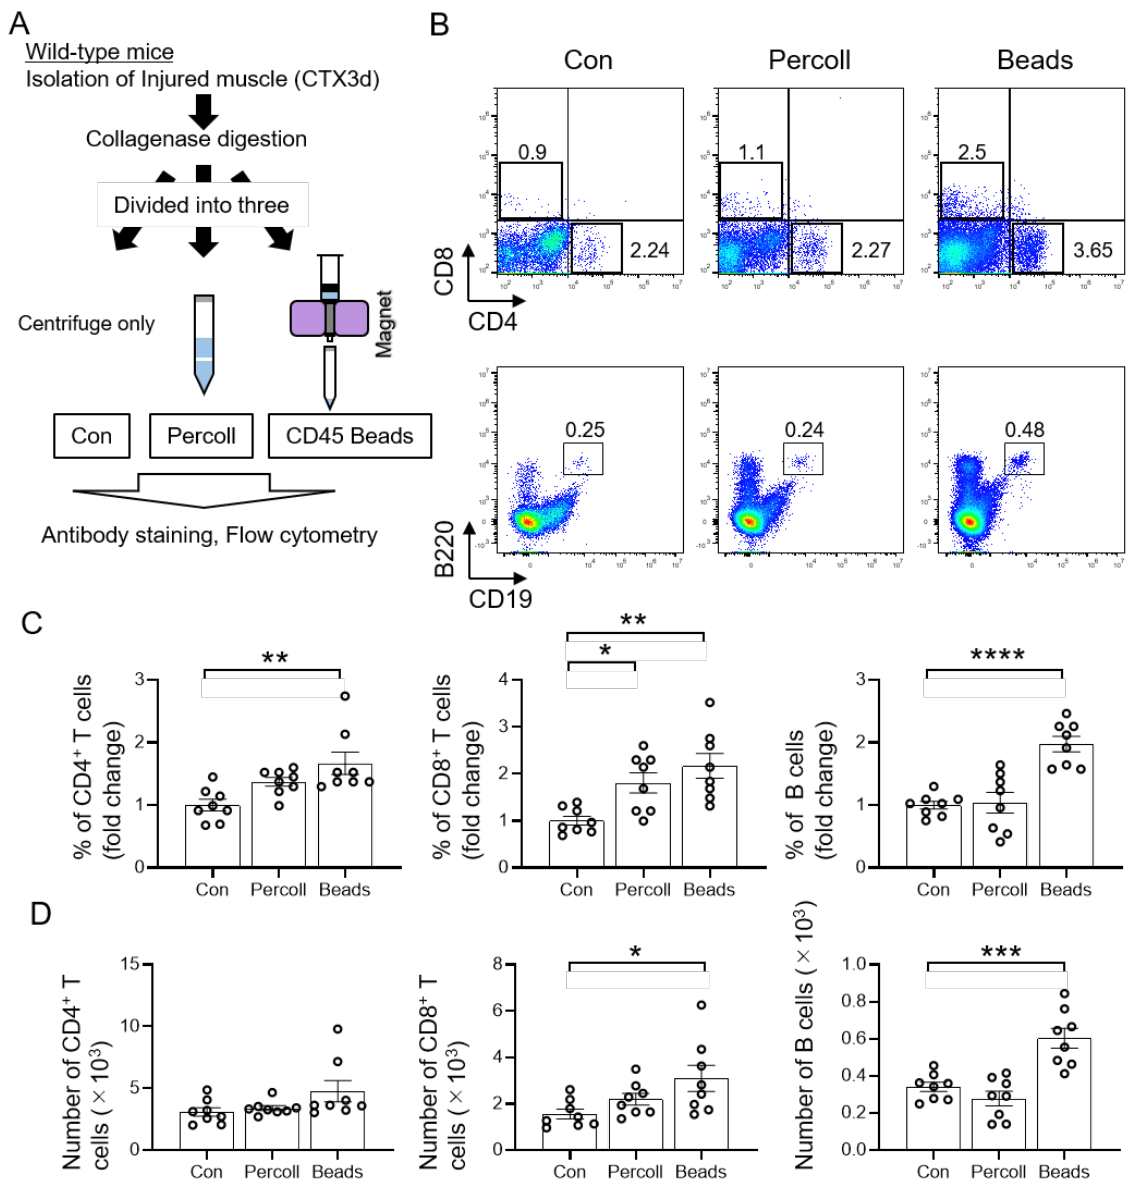
Figure 2. Isolation of T and B cells from injured muscle using CD45 beads is efficient. ( A ) Schematic representation of the experimental workflow for the analysis of injured muscle on day 3 after injury with Percoll and CD45 beads isolation methods in wild-type mice. ( B ) Flow cytometry analysis profiles of muscle-derived CD4 + T cells (helper T cells), CD8 + T cells (cytotoxic T cells), and B cells on day 3 after injury. The gated profiles show T cells (CD4 + or CD8 + ) and B cells (B220 + CD19 + ). ( C ) Fold change in the percentage of CD4 + T cells, CD8 + T cells, and B cells in the Percoll and CD45 bead groups relative to the control group. (D) The number of T and B cells were analyzed. Data represented as the mean ± SEM (one-way ANOVA followed by Dunnett’s post hoc test: * = p < 0.05, ** = p < 0.01, *** = p < 0.001, **** = p < 0.0001; n = 8 per